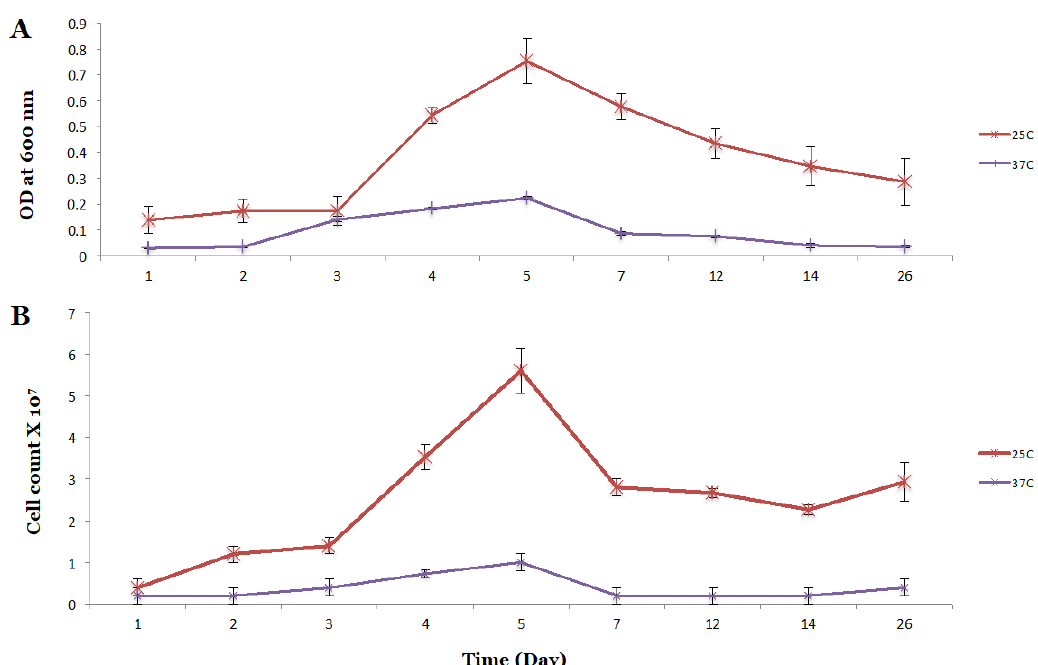
Figure 1. Growth comparison of Clostridium carboxidivorans P7 wild type employing two different temperatures 25 ◦ C and 37 ◦ C in the optimized 1754-B medium. ( A ) Optical density, ( B ) Cell count. When cells grew on the 1754-B medium at 25 C under CO 2 conditions only (absence of CO), three products, including formic acid, acetic acid, and ethanol and a trace amount of butyric